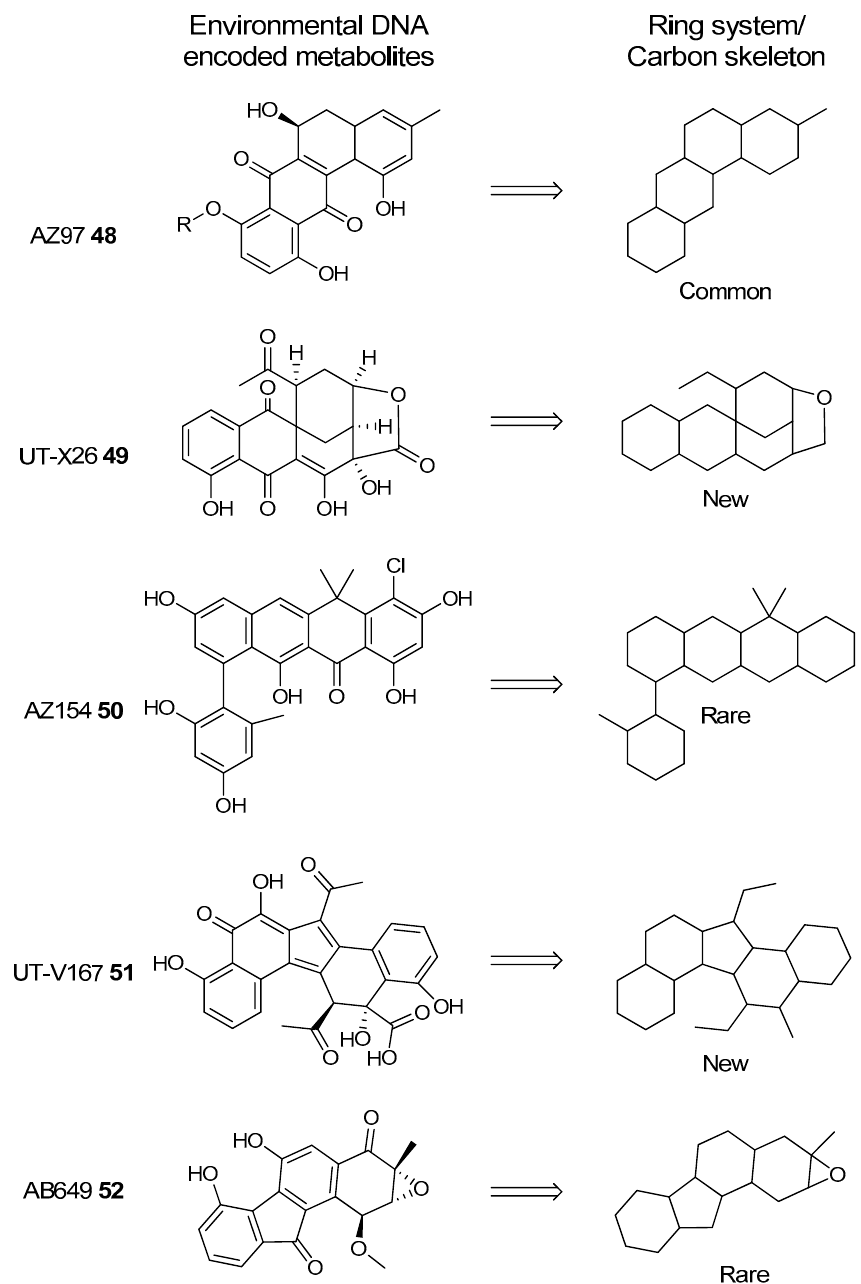
Figure 14. Type II polyketides found in metagenomic libraries from desert soils and their ring systems. Reproduced with permission from Feng et al., Proc. Natl. Acad. Sci. USA. , published by United States National Academy of Sciences, 2011 [187].